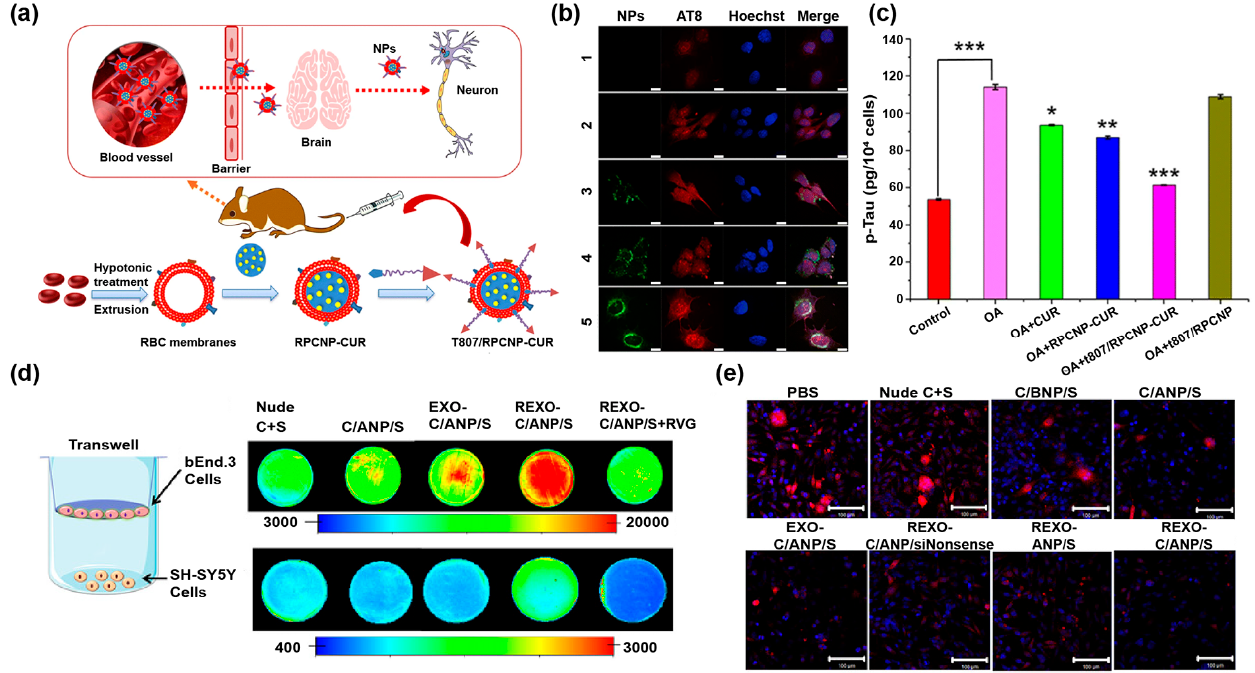
Figure 5. ( a ) Schematic illustration of the preparation of T807/RPCNP-CUR NPs and their application for AD. ( b ) CLSM images of okadaic acid (OA)-treated HT22 cells treated with different NPs after 4 h incubation (Nuclei were stained with blue fluorescence; p-Tau was shown in red fluorescence; COU-labeled PCNP, RPCNP, and T807/RPCNP were shown in green fluorescence. 1: control; 2: OA; 3: OA + PCNP-COU6; 4: OA + RPCNP-COU6; 5: OA + T807/RPCNP-COU6. Scale bars = 100 μ m). ( c ) Elisa analysis of cellular total p-Tau levels after treatment with different NPs in OA-treated HT22 cells. Here, *** indicates p < 0.001, ** indicates p < 0.01, and * indicates p < 0.05, respectively (compared to the OA group). Reproduced with permission from [33], Copyright 2020, Springer Nature. ( d ) Scheme of the Transwell system and the internalization of different nanomaterials in bEnd.3 cells (top) and SH-SH5Y cells (bottom). ( e ) The expression of α -syn in SNCA–mCherry–SH-SY5Y cells after treatment with different NPs (Scale bars = 100 μ m). Reproduced with permission from [105], Copyright 2020, AAAS.